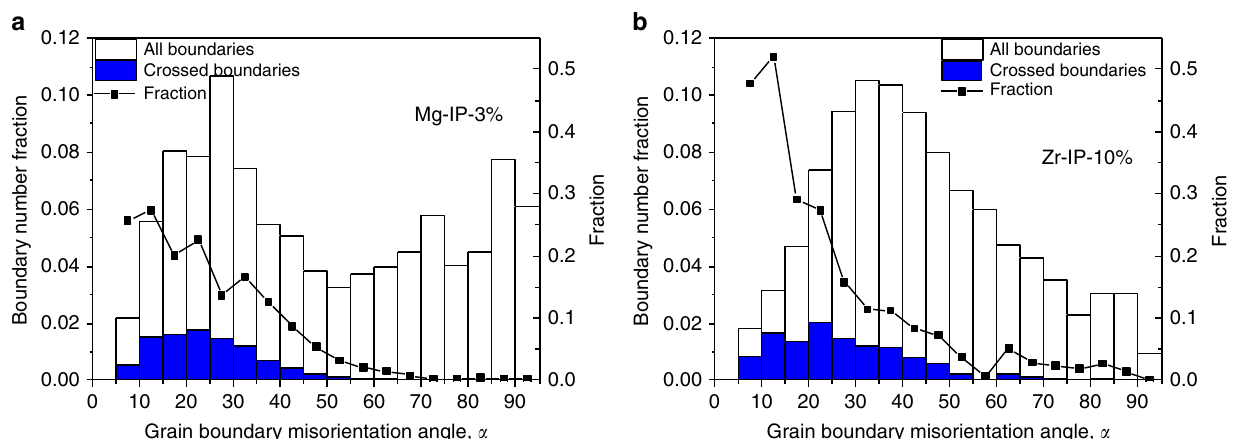
Figure 2 | EBSD-based evolution of twin transmission frequency. EBSD-based distribution of grain boundaries and twin crossing at grain boundaries with grain boundary misorientation angle for ( a ) Mg and ( b ) Zr. White bars: all grain boundaries; blue bars: twin-crossed boundaries. The secondary vertical axis shows the fraction of grain boundaries that have been crossed by twins. Non-zero crossed boundary fraction beyond 60 (cid:2) for Zr can be a consequence of local stress deviations associated with clusters of small-sized grains where twin variants with negative ‘macroscopic’ Schmid factor are